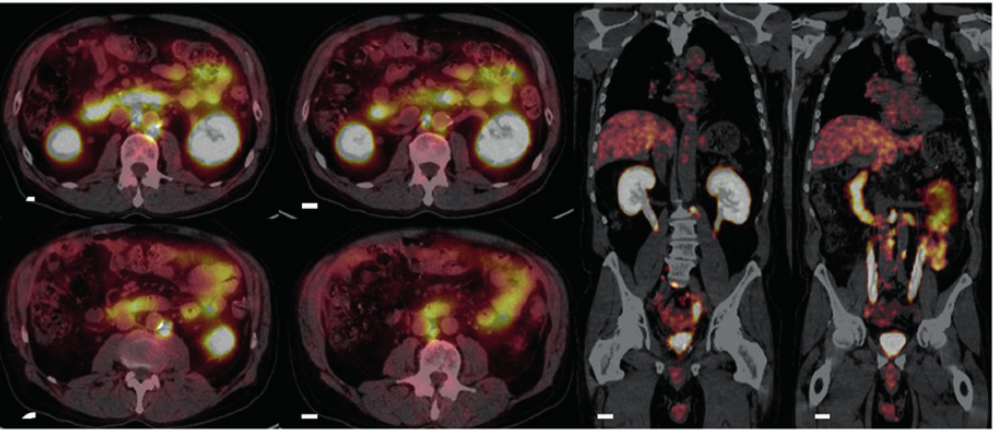
figure 1 - Example of patient submitted to 68 Ga-pSMA pET/cT due to biochemical recurrence. The prior cT images and MRI performed were negative for metastases. The 68 Ga-pSMA pET/cT images demonstrate normal size lymph nodes that are avid for 68